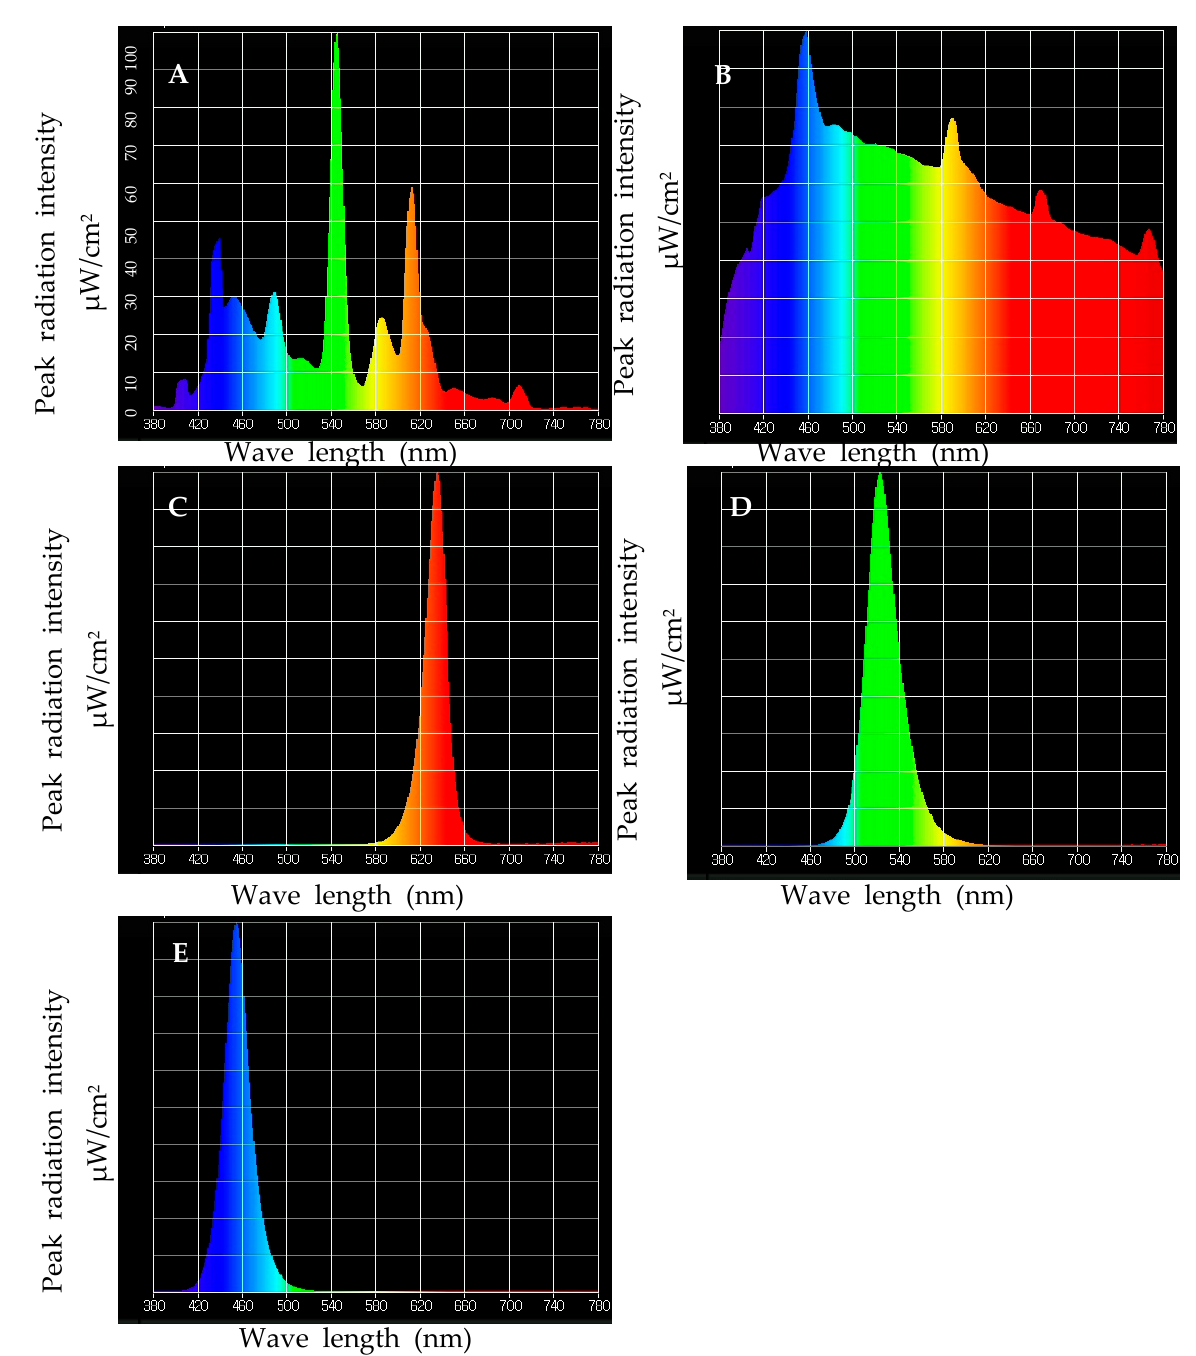
Figure 1. Spectral distribution of light in the growth chamber. ( A ) FL, ( B ) MEL, ( C ) red LED, ( D ) green LED, and ( E ) blue LED. FL: Fluorescent light, RL: red LED, BL: blue LED, GL: green LED, MEL: micro-electrodeless light, and UL: Ultra sound+ FL.